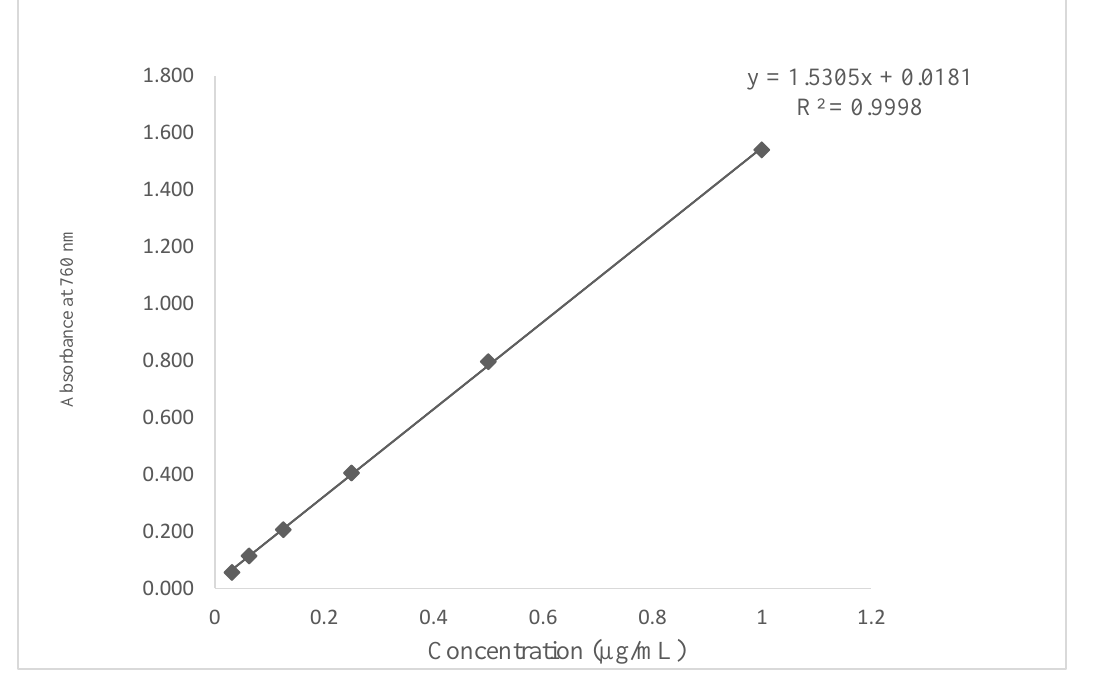
Figure 1. Total phenolic content of standard gallic acid (R² values are a representation of the mean data set of n = 3.